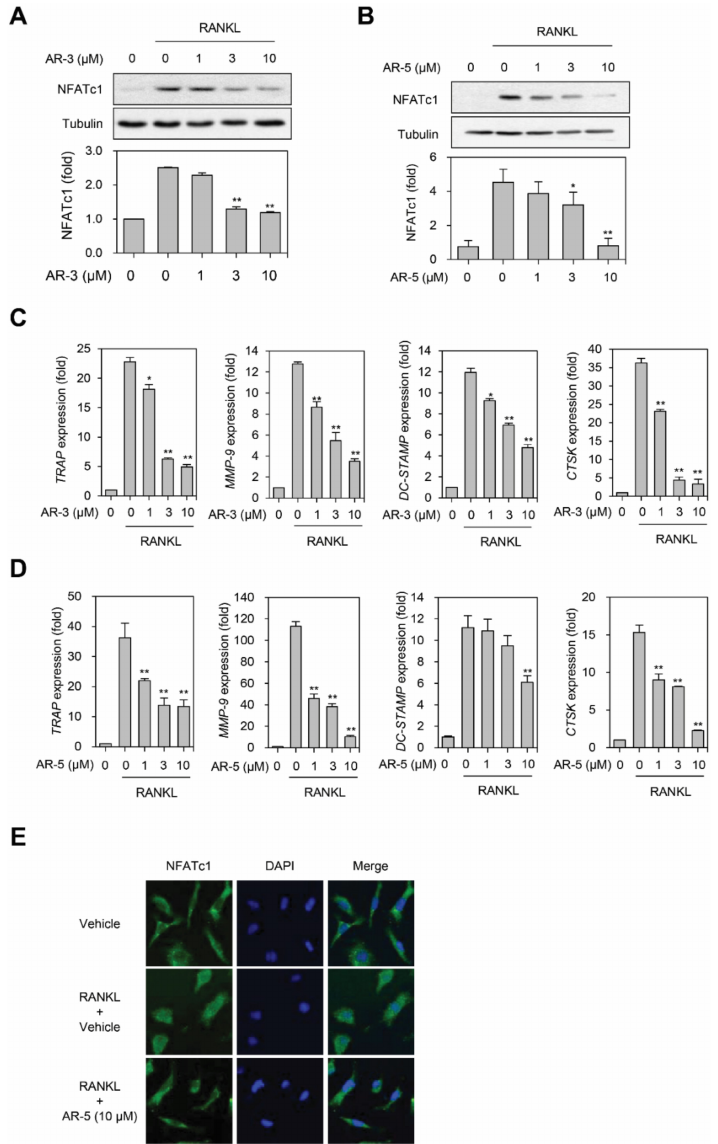
Figure 5. AR-3 and AR-5 inhibit RANKL-induced NFATc1 activation and its target gene expression. ( A , B ) RAW264.7 cells were stimulated with RANKL in the presence of the indicated concentrations of AR-3 ( A ) or AR-5 ( B ) for 48 h. The expression level of NFATc1 was determined by western blotting. Graphs represent densitometry analyses normalized to tubulin (* p < 0.05 and ** p < 0.01, versus vehicle-treated control, n = 3). ( C , D ) BMMs were incubated with M-CSF and RANKL in the presence of indicated concentrations of AR-3 ( C ) or AR-5 ( D ) for four days. Reverse transcription qPCR analysis was performed to quantify the mRNA expression levels of TRAP, MMP-9, DC-STAMP , and CtsK . Data are presented as the mean ± SE (* p < 0.05 and ** p < 0.01, versus the vehicle-treated control; n = 5). ( E ) BMMs were stimulated with RANKL and M-CSF in the presence or absence of AR-5 (10 µ M) for three days. The cells were fixed and stained with an anti-NFATc1 antibody, followed by an Alexa Fluor 488-conjugated secondary antibody. DAPI was used to stain